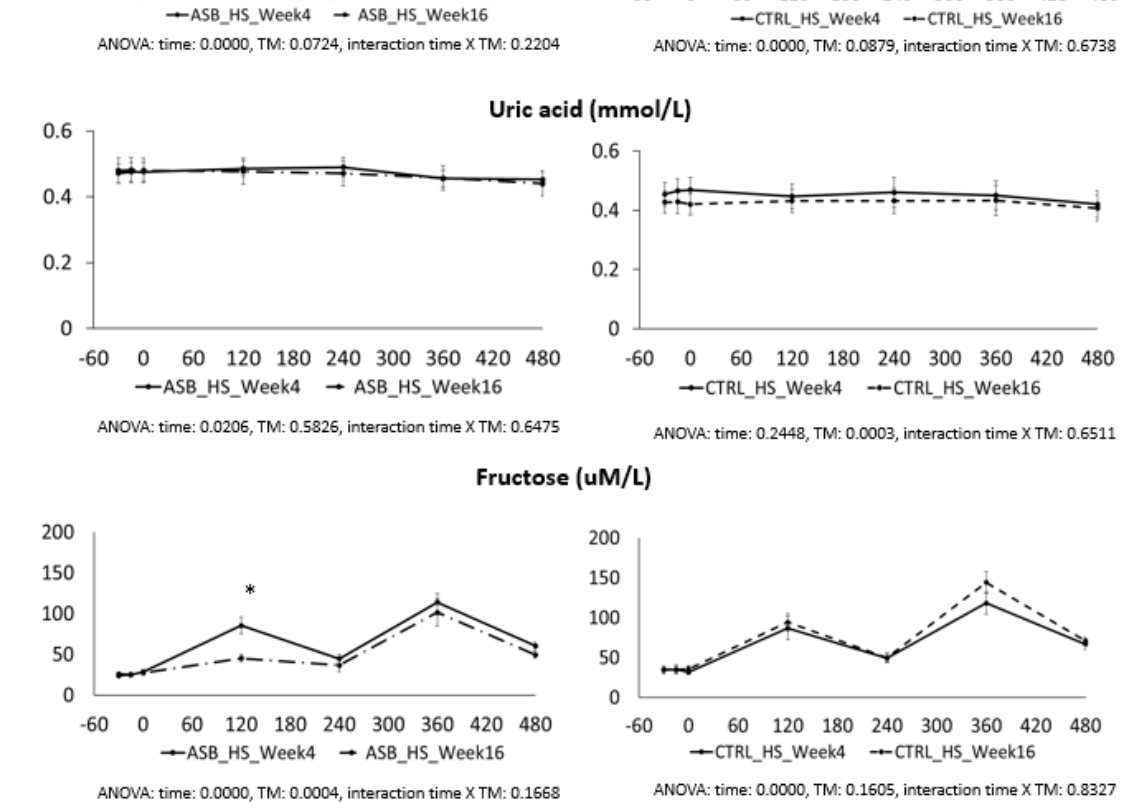
Figure 6. Plasma concentrations of TG, NEFA, uric acid, and fructose in participants with hepatic steatosis. Data are expressed as mean ± SEM.; solid lines correspond to week 4, dotted lines to week 16. Results for ASB arm are shown on the left part, and for CTRL arm on the right part of the graph. Statistics (two ‐ way ANOVA for repeated measurements with interaction) are reported at the bottom of each graph.